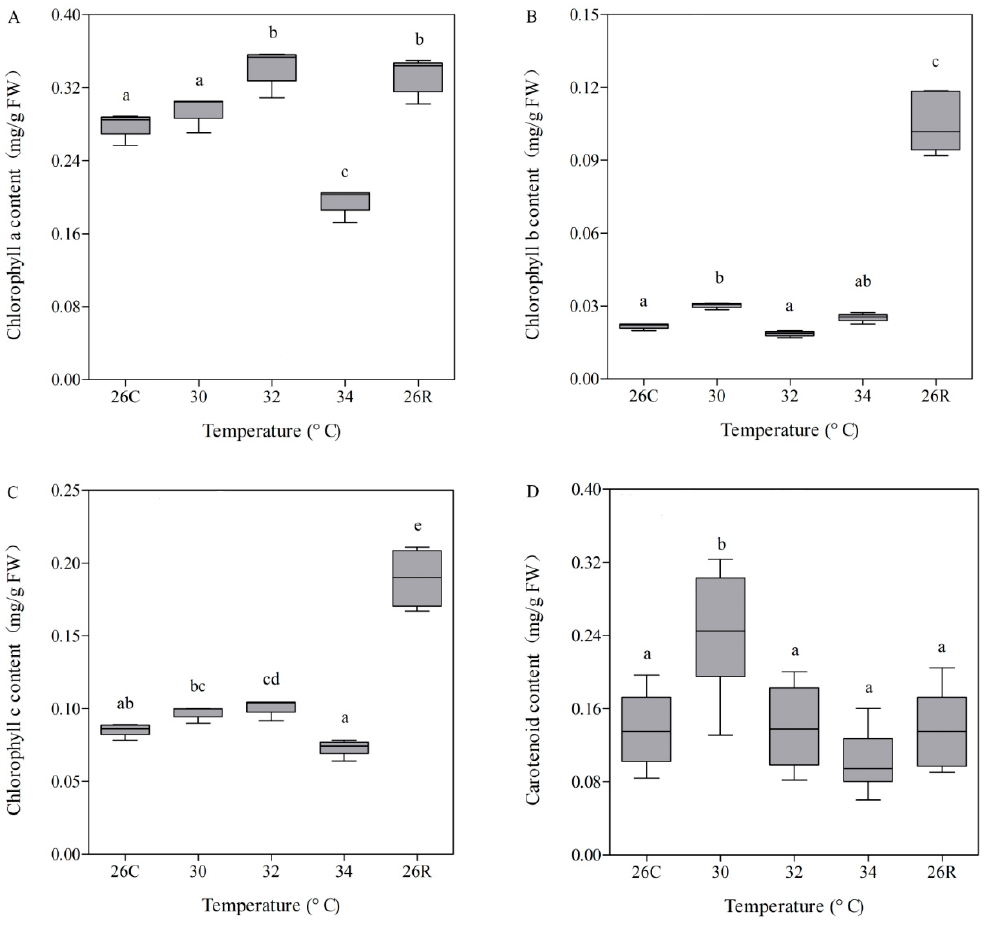
Figure 4. Contents of photosynthetic pigments, including chlorophyll a, b, and c ( A – C , respectively) and carotenoids ( D ), in Pocillopora sp. tissue at different temperatures (means ± SEs). The coordinates 26C and 26R represent the 26 ◦ C control and 26 ◦ C recovery, respectively. Five biological samples ( n = 5) were collected at the last moment of each temperature gradient for photosynthetic pigment determination. The data were subjected to nonparametric Kruskal–Wallis tests (same letters: no significant difference; different letters: significant difference, p <